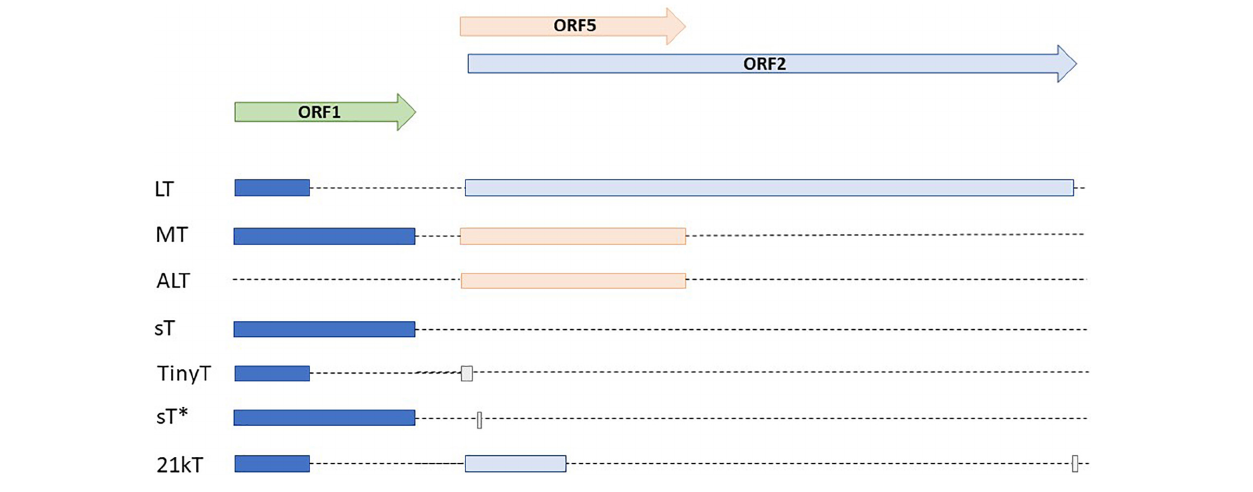
FIGURE 3 | Alternative early transcripts of TSPyV. Modified after (van der Meijden et al., 2015; van der Meijden and Feltkamp,